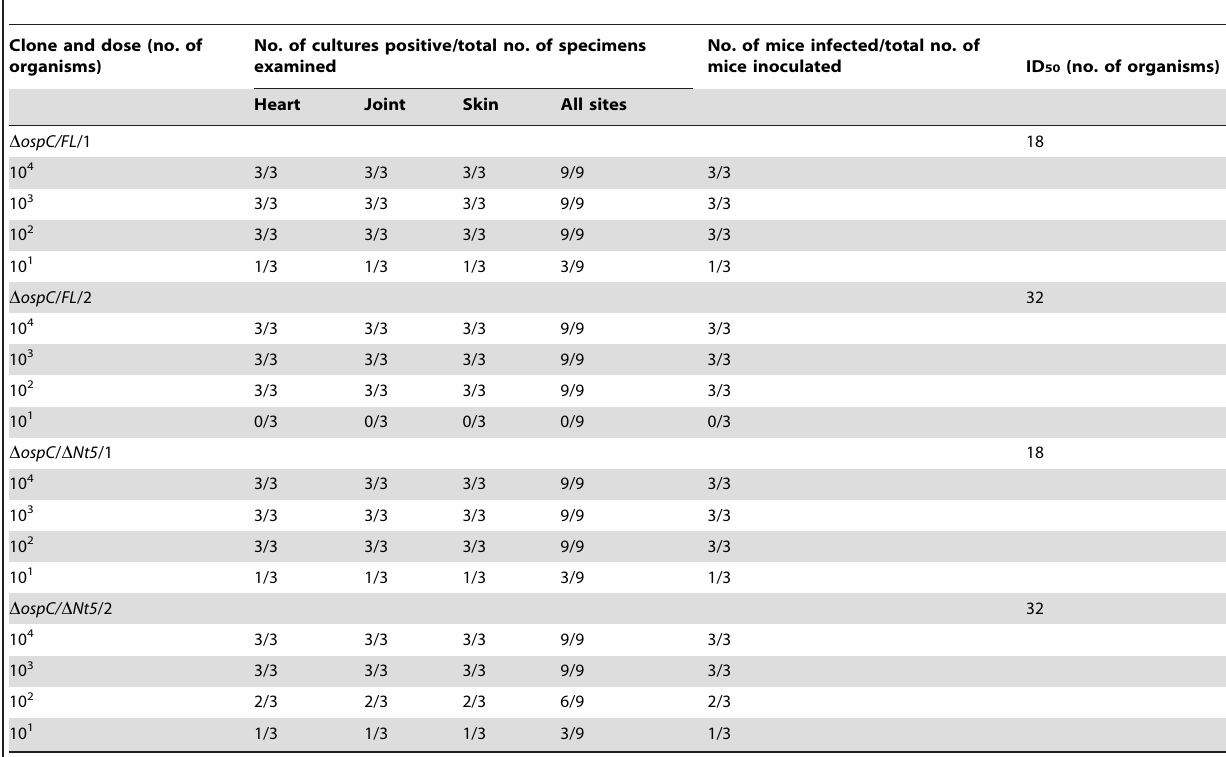
Table 4. The 5-AA deletion does not significantly affect the ID 50 value in immunodeficient mice a .